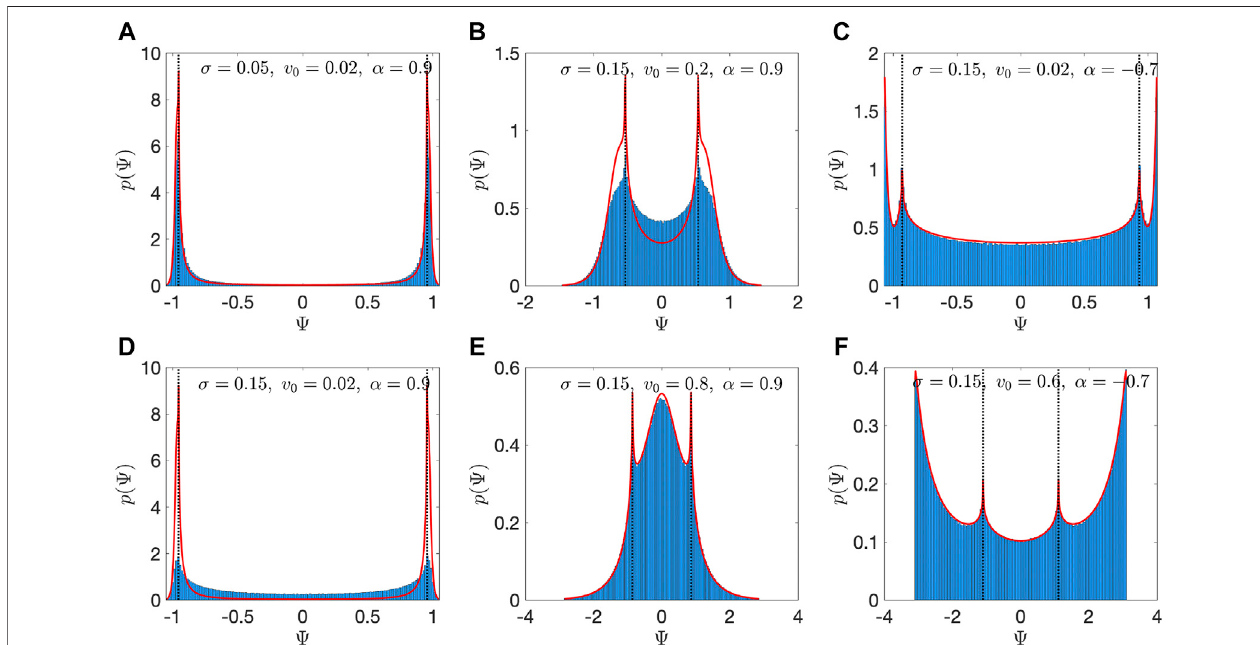
FIGURE 9 | Comparison of the steady-state Ψ distributions from the averaging principle [ p 0 ( Ψ ), red curves] and those obtained from solving the Fokker-Planck Equation 12 and applying Eq. 42 . The parameters are the same as in Figure 4 . Panels A – D are for parameters before the bifurcation from rotational to cross-stream drift, and panels E and F are after this bifurcation. Black dotted lines indicate the Ψ values of the separatrices ± Ψ s . Note that p 0 ( Ψ ) does not depend on σ , so the curves plotted in panels (A) and (D) are the